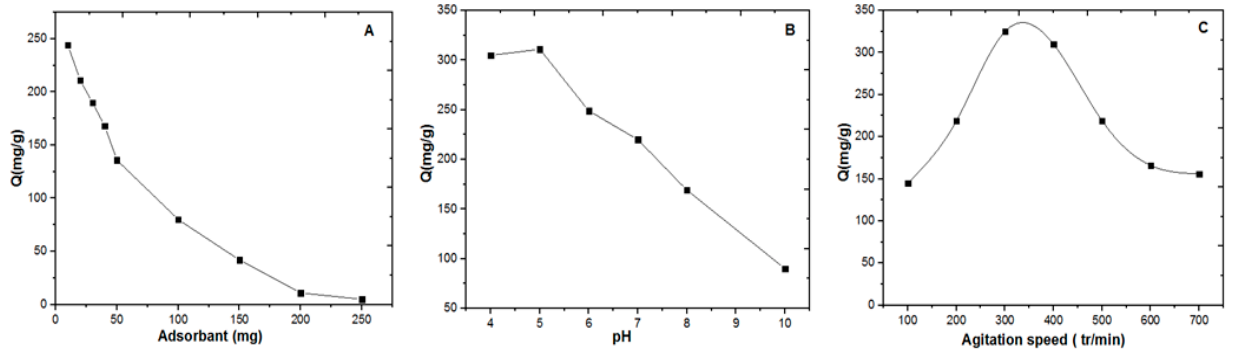
Figure 2. Evolution of the adsorption capacity of MeO dye as a function of: ( A ) adsorbent mass, ( B ) pH, ( C ) Agitation speed .